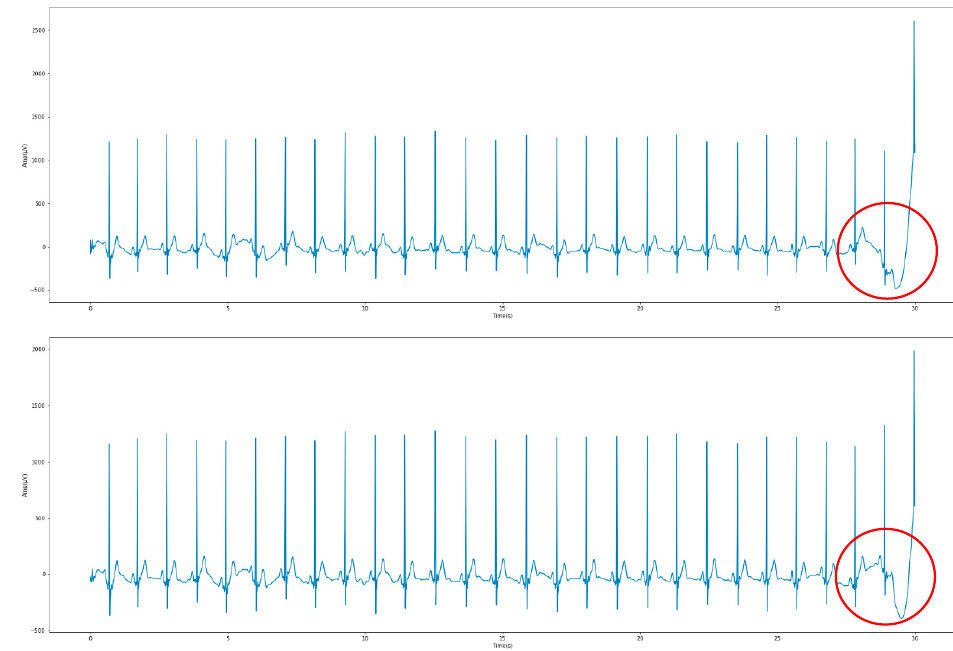
Figure 2. Differences before and after filtering.